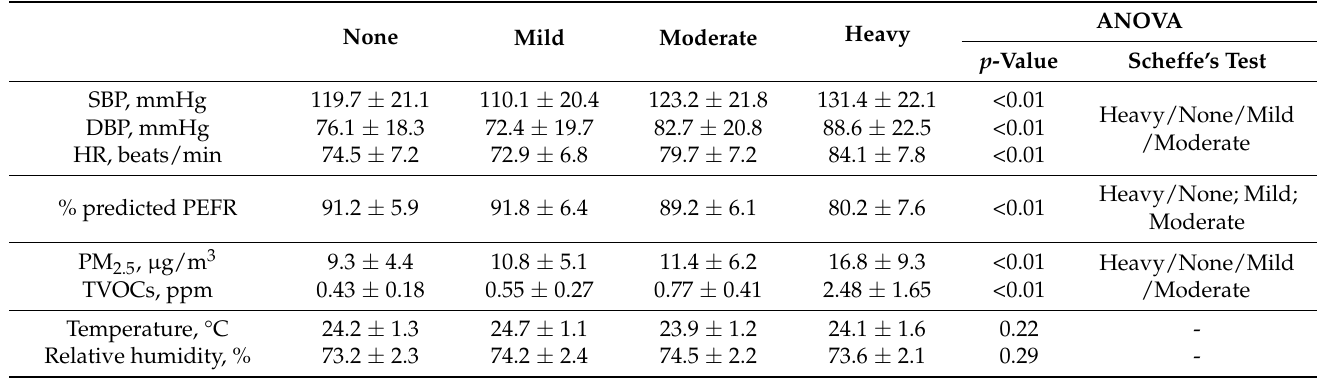
Table 2. The statistical summary for peak expiratory flow rate, blood pressure, and heart rate at 1-h mean and environmental measurements at 1-h mean among 200 participants from 2008 to 2018 * (mean ± standard